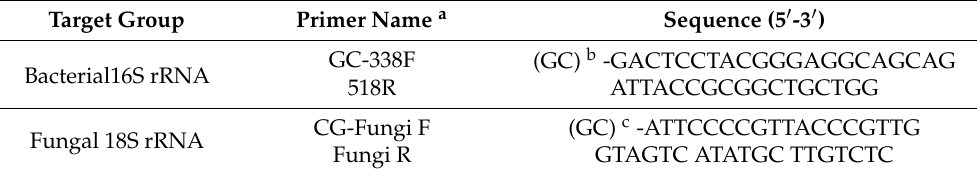
Table 1. PCR primers used in the present study